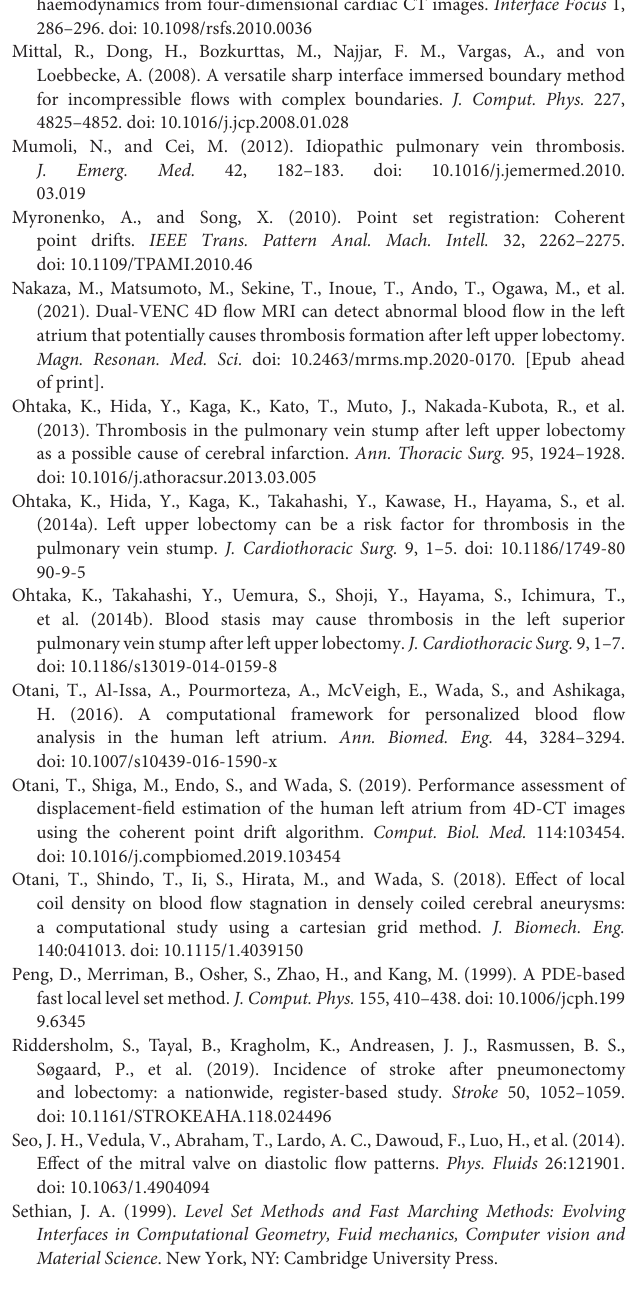
Supplementary Video 2 | Anterior view of the vortex structure transition in the left atrium before and after the left upper lobectomy throughout a cardiac cycle. Supplementary Video 3 | Cross-sectional views of the velocity magnitude, finite-time Lyapunov exponent (FTLE), and Lagrange coherent structure (FTLE iso-surface) in the left atrium before and after the left upper lobectomy throughout a cardiac